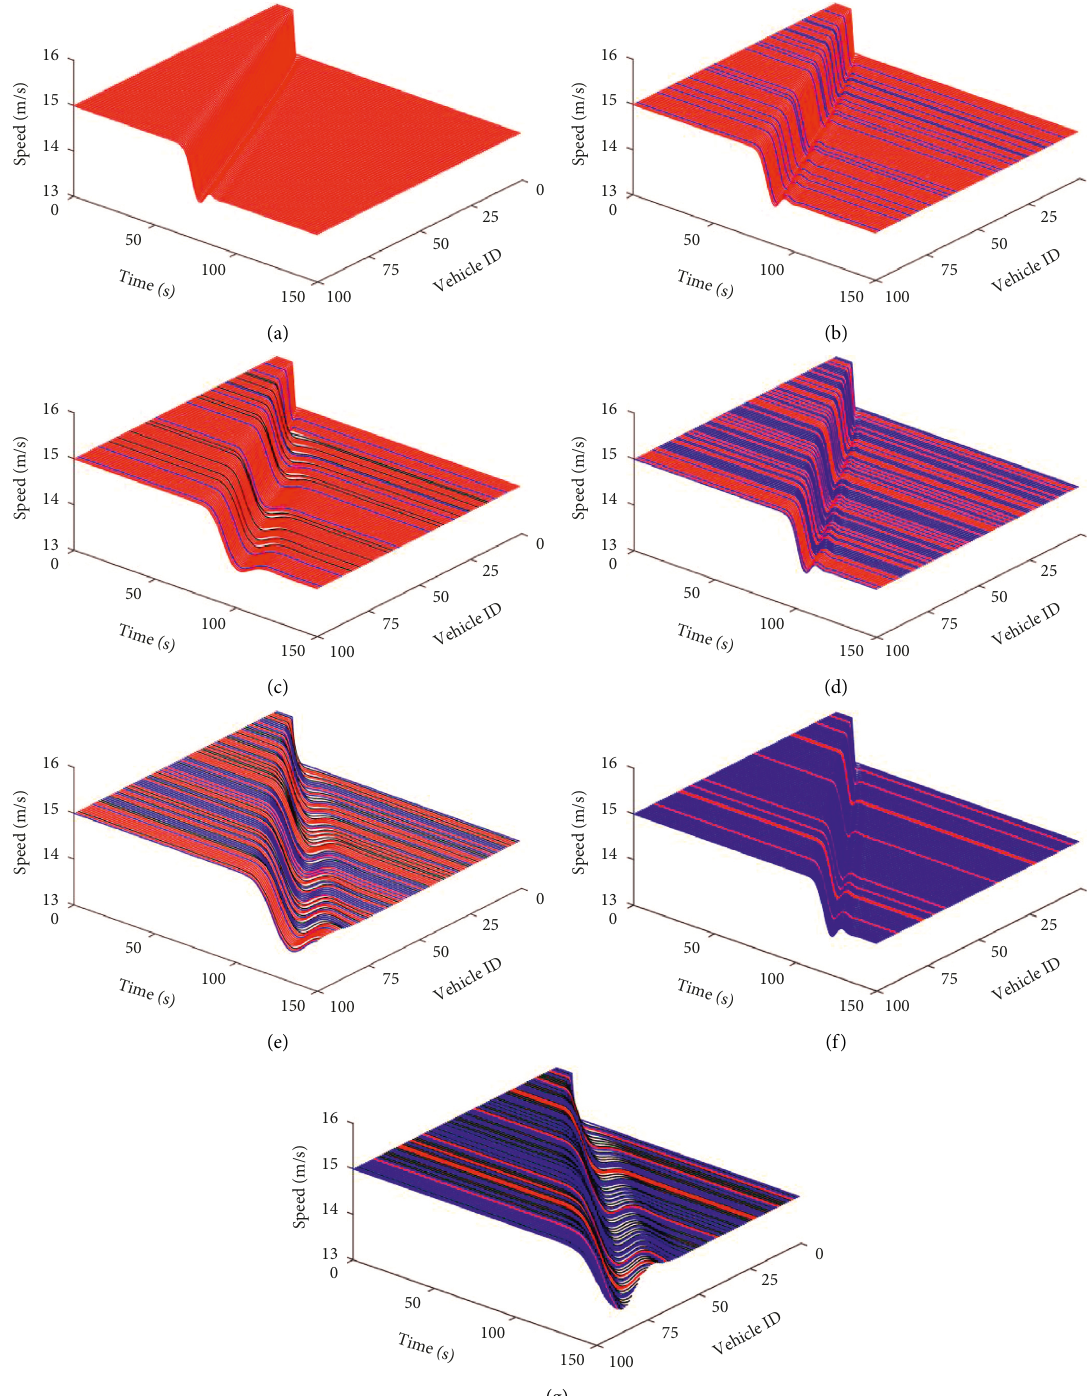
Figure 8: Vehicle dynamics under communication failures for incidents analysis. (a) p � 0 ,q � 0. (b) p � 0 . 3 ,q � 0. (c) p � 0 . 3 ,q � 0 . 6. (d) p � 0 . 6 ,q � 0. (e) p � 0 . 6 ,q � 0 . 6. (f) p � 0 . 9 ,q � 0. (g) p � 0 . 9 ,q � 0 .